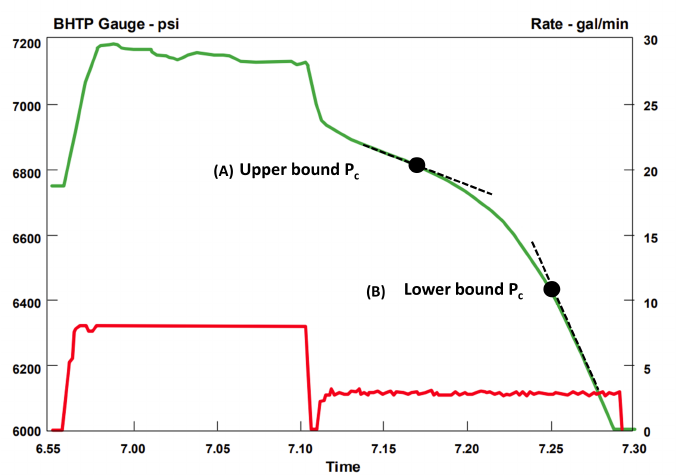
Figure 5. Flowback test showing upper and lower bounds of fracture closure pressure